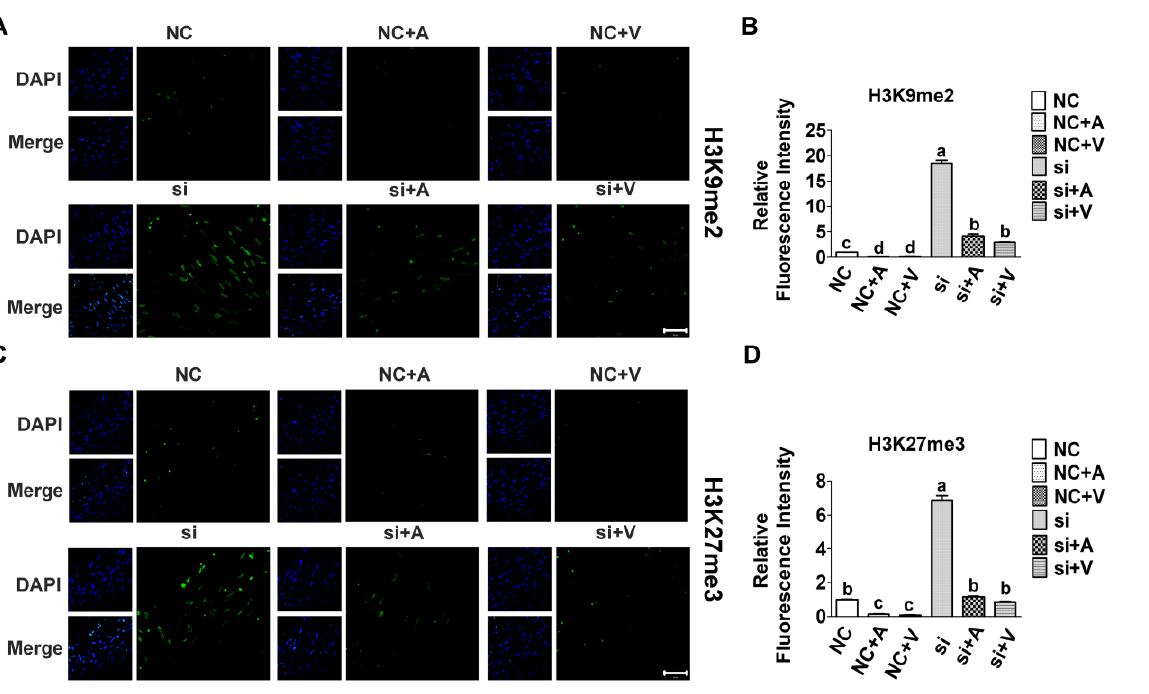
Figure 5. Level of H3K9me2 and H3K27me3 in myoblasts treated by 5-AZA and VC after Tet2 knockdown. Level of H3K9me2 ( A , B ) and H3K27me3 ( C , D ) in 5-AZA or VC group was detected by immunofluorescence. ( B , D ): Relative fluorescence intensity of H3K9me2 (green) and H3K27me3 (green) was analyzed. The nuclei were counterstained with DAPI (blue). Scale bar: 50 μm. Error bars show mean ± SEM of biological replicates ( n = 3). Different letters indicate significant difference ( p < 0.05).